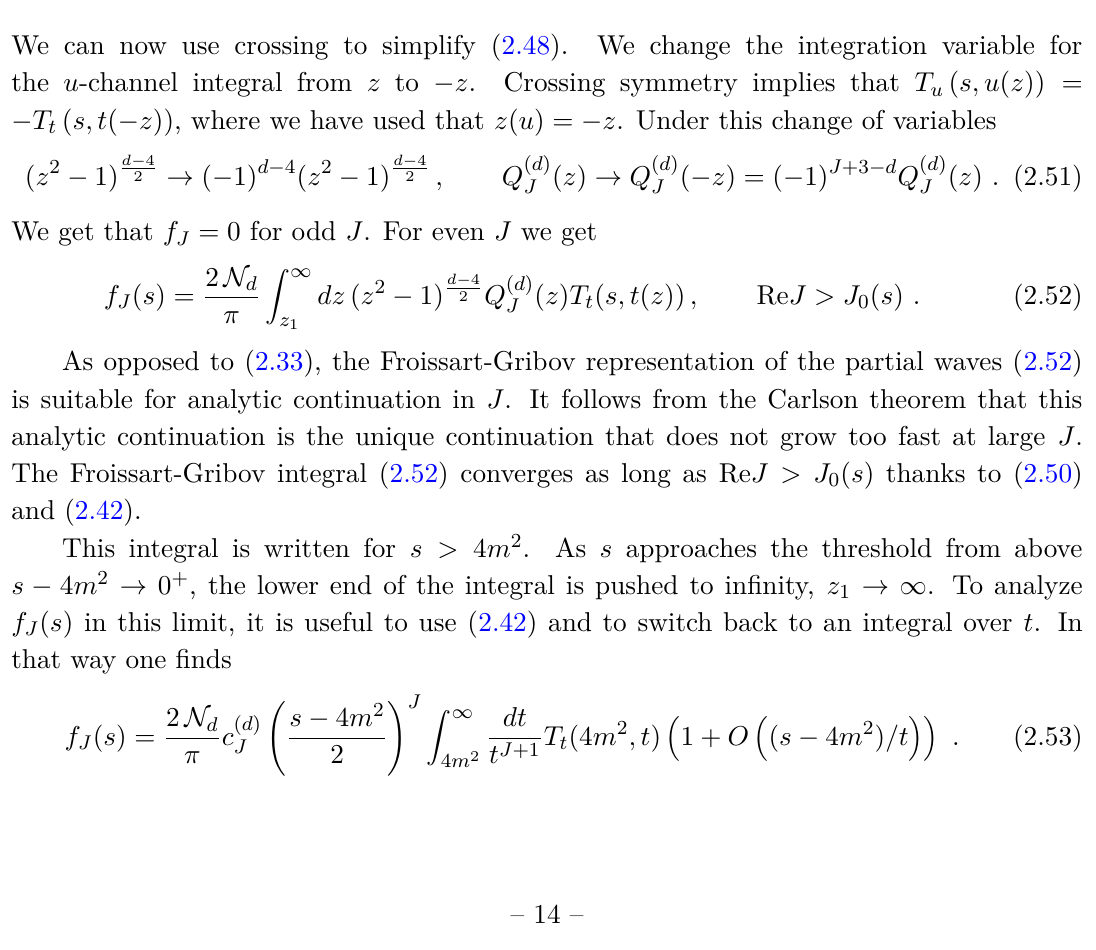
Figure 2 . (a) The partial wave projection integral (2.47) is a contour integral (in blue) that circles around the cut of the Q -function, between t = 0 and t = − ( s − 4 m 2 ) , (in red). (b) We partially open up the contour. Sometimes this representation for partial waves is called the truncated Froissart- Gribov formula. The advantage of this representation is that we only use a finite amount of extended analyticity that has not been rigorously proven. (c) We open the contour all the way to infinity and arrive at the usual Froissart-Gribov formula (2.48) with two integrations of the discontinuity of the amplitude along the t -channel and u -channel cuts (in